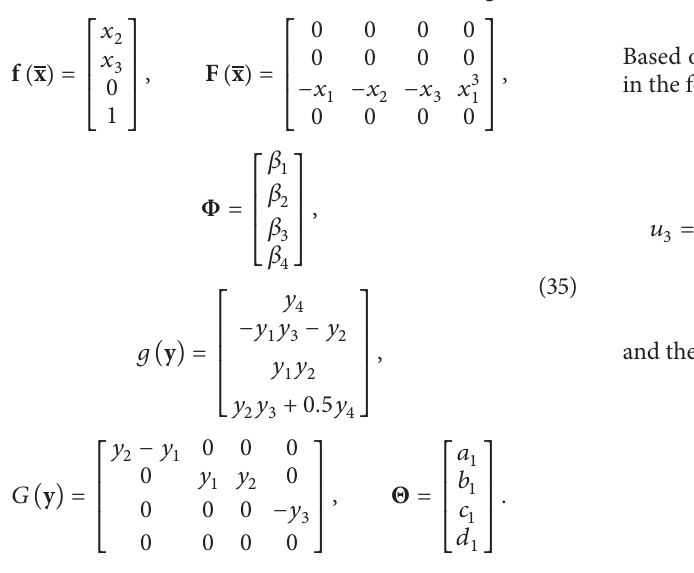
Figure 4: Time evolution of parameter estimations for system